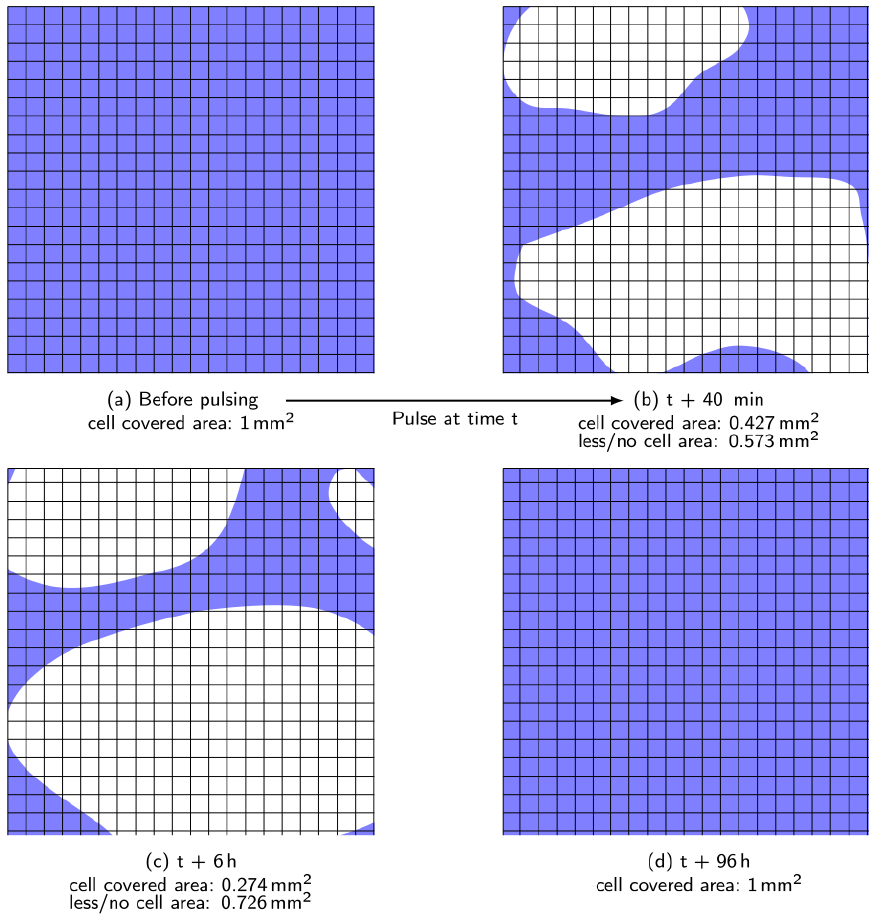
Figure 9. Schematic picture showing only the electrode area (1 × 1 mm 2 , grid dimensions 50 × 50 µ m 2 ) corresponding to Figure 8. ( a ) and ( d ) showing fully cell covered electrode areas (blue) before and 96h after pulsing; ( b ) shows decreasing cell covered area and increasing area without or less cells in white; ( c ) demonstrates increased white area after about 5 h compared to ( b ) and therefore even fewer cells remain on the electrode.